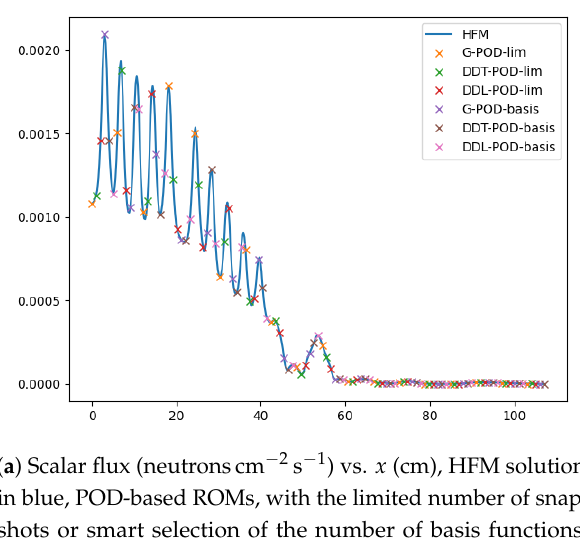
for all POD-based ROMs, with the limited number of snap- shots or smart selection of the number of basis functions, in crosses. Figure 17. Scalar flux for Energy Group 1 for the HFM (blue) and POD-based ROMs, with the limited number of snapshots or smart selection of the number of basis functions, in crosses, and the pointwise error between them with parameters R 1 = 2, R 2 = 2, R 3 = 1, R 4 = 1, R 5 = 4.